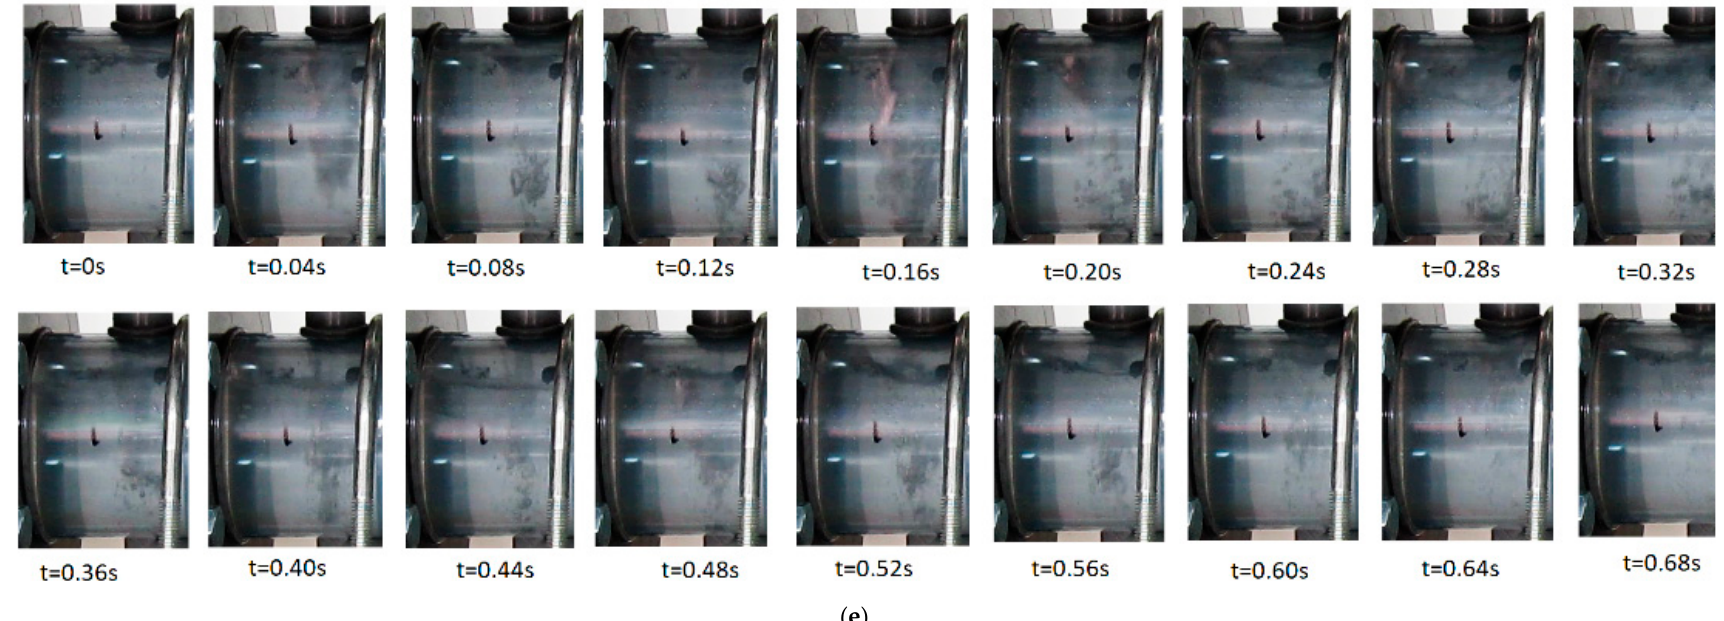
Figure 3. ( a ) Cavity formation at an inlet momentum of 200 Pa; ( b ) Cavity formation at an inlet momentum of 400 Pa; ( c ) Cavity formation at an inlet momentum of 600 Pa; ( d ) Cavity formation at an inlet momentum of 800 Pa; ( e ) Cavity formation at an inlet momentum of 1000 Pa.